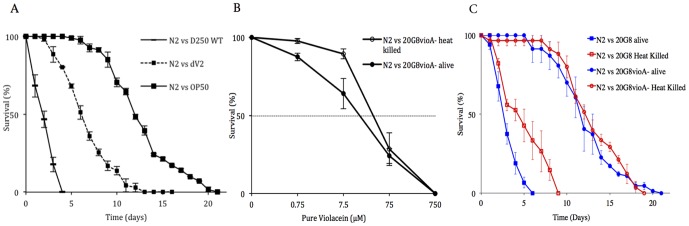
Nematode killing assay and dose response assay (N2 animal vs the alive and heat killed 20G8 clone and D250 strains).(A) Killing kinetics of Microbulbifer sp. D250 and dV2 mutant deficient in violacein production. Negative control OP50 is a non-pathogenic strain of E. coli. (B) Dose response of C. elegans to pure violacein added to 20G8vioA− mutant bacteria alive and heat killed. Each point on the graph represents the average survival of worms after seven days exposure to violacein (C) Kinetics of nematode killing when nematodes are fed either the live or heat killed 20G8 clone or 20G8vioA− mutant. Each data point represents means ± the standard error of three replicate plates. p values were calculated on the pooled data of all of the plates in each experiment by using the log-rank (Mantel–Cox) method.